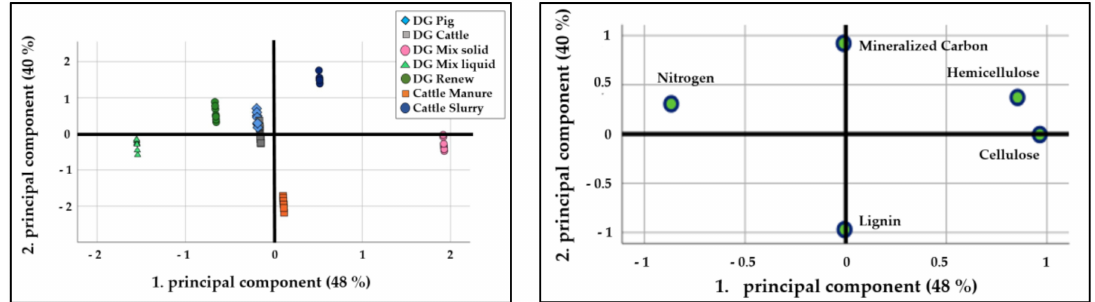
Figure 7. Factor scores ( left ) and loading plot ( right ) of the two principal components from di ff erent variables describing 56